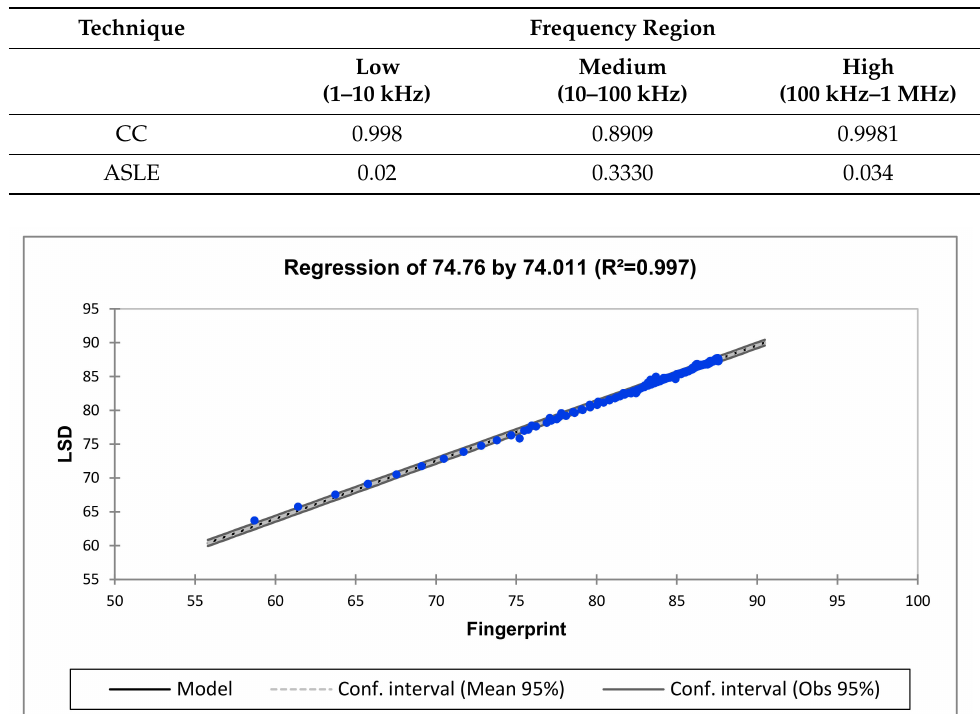
Figure 10. Regression analysis for fingerprint vs. after deformation (lower-frequency